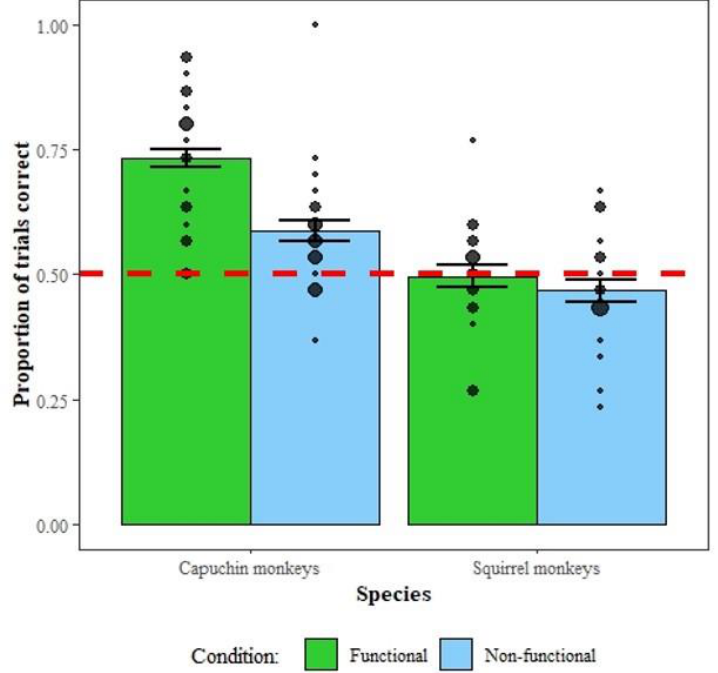
Note . The error bars show the mean ± standard error, with the red dashed line indicating chance. The points indicate the average score for individual participants, with the size of the point reflecting the number of individuals at any one